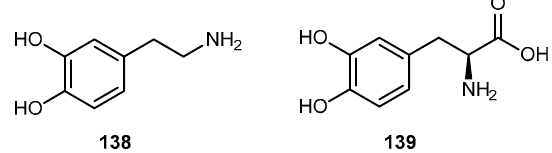
Figure 56. Chemical structure of dopamine ( 138 ) and its prodrug levodopa ( 139